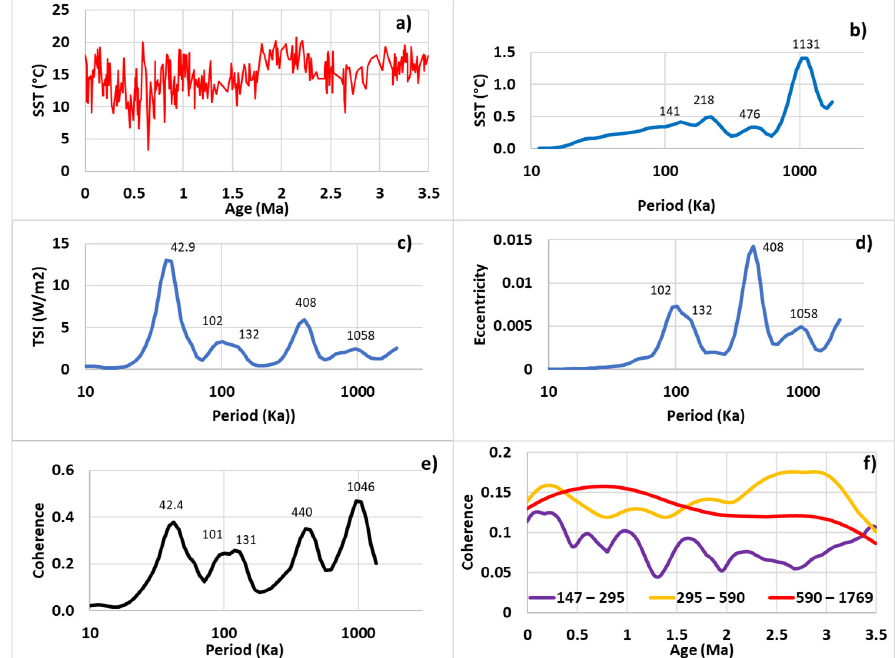
Figure 4. Data used in the present study—( a ) Alkenone concentration vs. time at DSDP Site 593 used as a proxy of Sea Surface Temperatures (SST)—( b ) Fourier transform (FT) of SST vs. time. Maximums of the peaks are in Ka—( c ) FT of Total Solar Irradiance (TSI)—( d ) FT of eccentricity variations—( e ) Coherence of TSI and SST vs. period—( f ) Coherence of TSI and SST vs. time. It turns out that the peak at 218 Ka is close to the period corresponding to the sub-